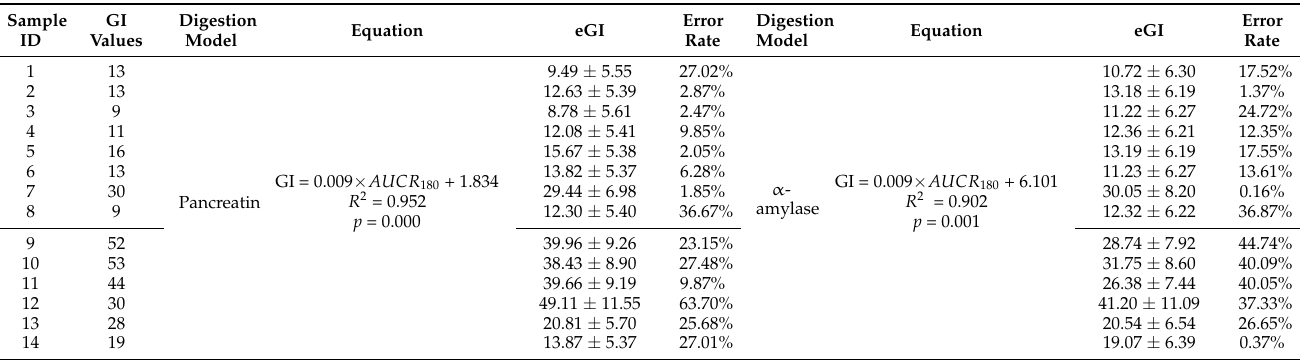
Table 5. Equations fitted to simple single-enzyme models (pancreatin and α -amylase) and predicted GI values for all